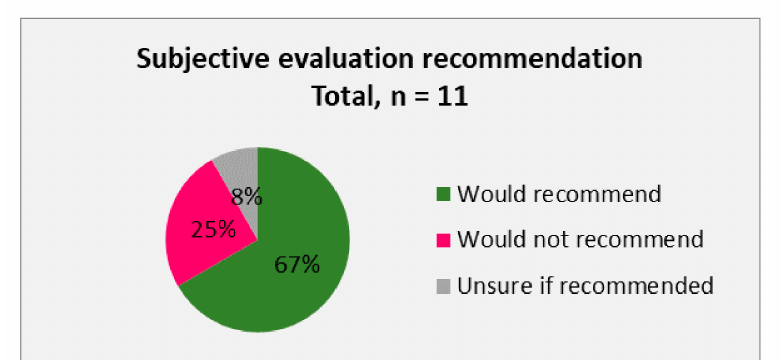
Figure 7. Subjective evaluation of the 11 patients on whether they would recommend the treatment of their knee osteoarthritis with freshly isolated SVF from the adipose